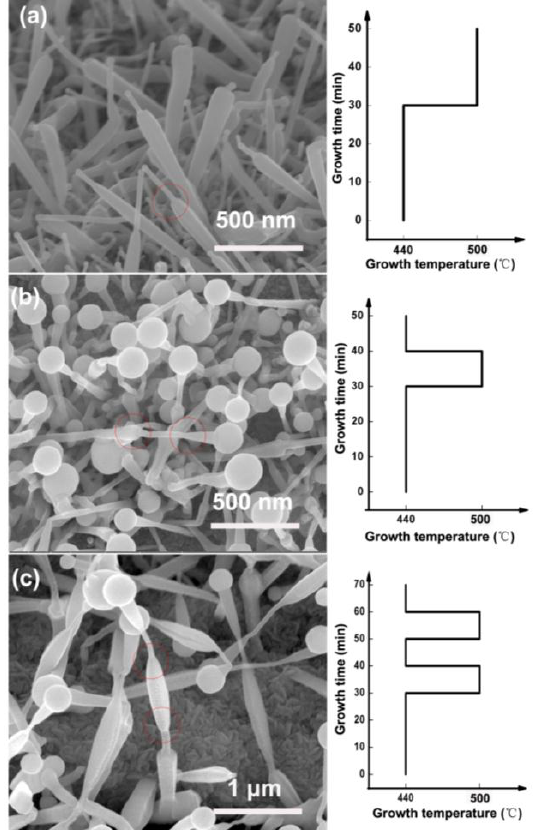
Figure 10. The nanowires formed in situ via temperature variation during the growth process. The growth procedures were illustrated at the right side of each SEM image. (a ) The nanowires grown at 440 °C for 30 min and then grown at 500 °C for 20 min. ( b ) The nanowires grown at 440 °C for another 10 min after the low-to-high temperature growth process. ( c ) The nanowires grown with an additional temperature variation step.